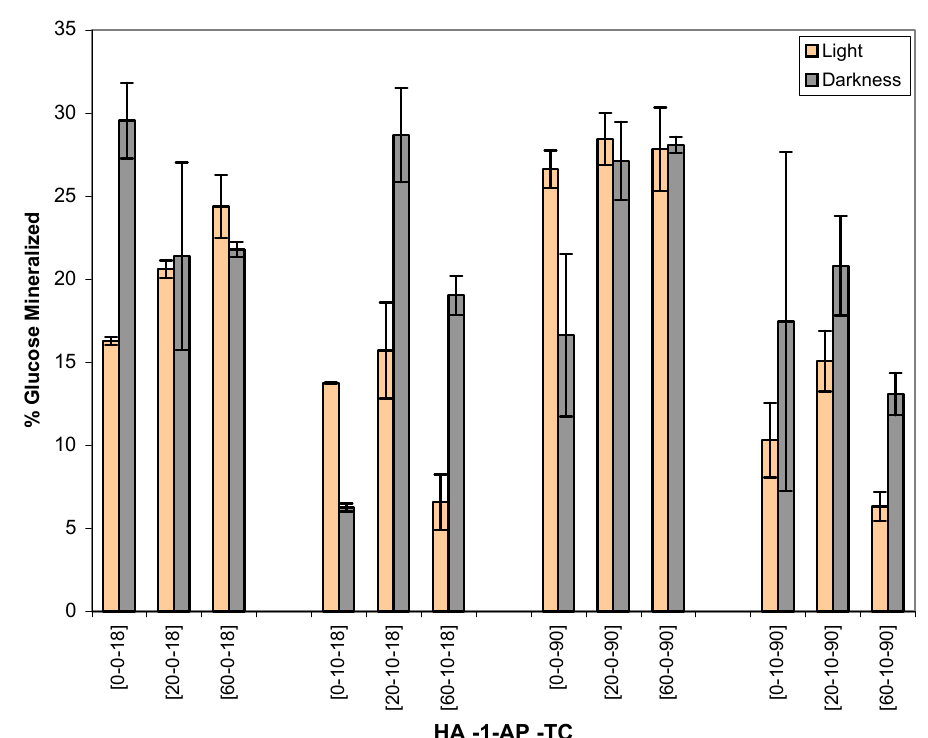
Figure 2. Amount of 14 C-D-glucose mineralized by heterotrophic bacteria (% ± STD) after exposure to1-AP in sunlight or darkness, in the absence and in the presence of HA, for 18 and 90 minutes. Units for x-axis labels: HA (ppm); 1-AP ( µ M); TC